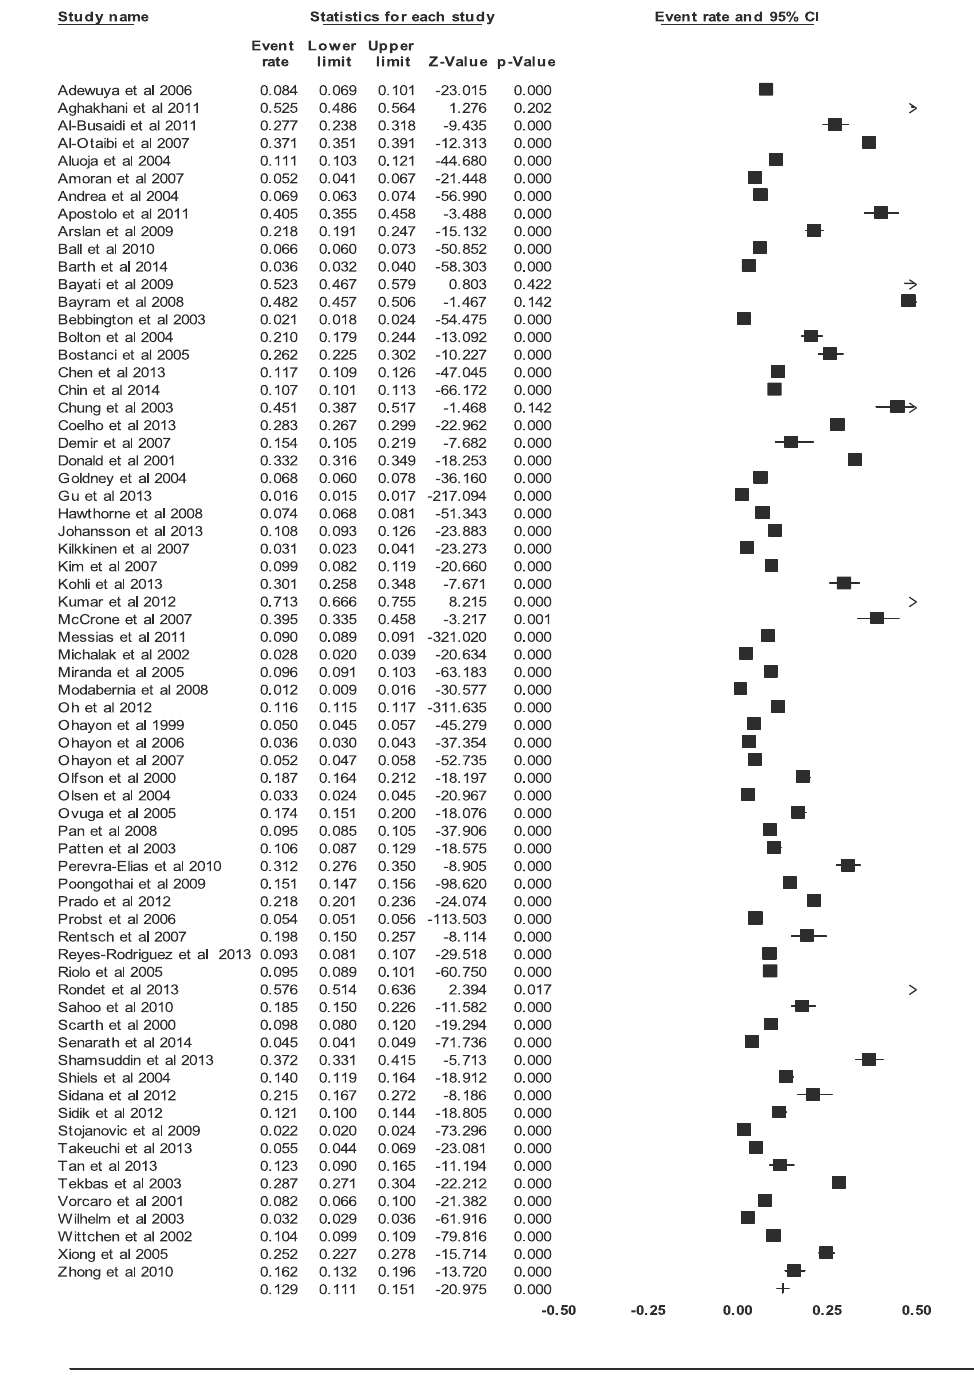
Figure 2. Forest plot of point prevalence of